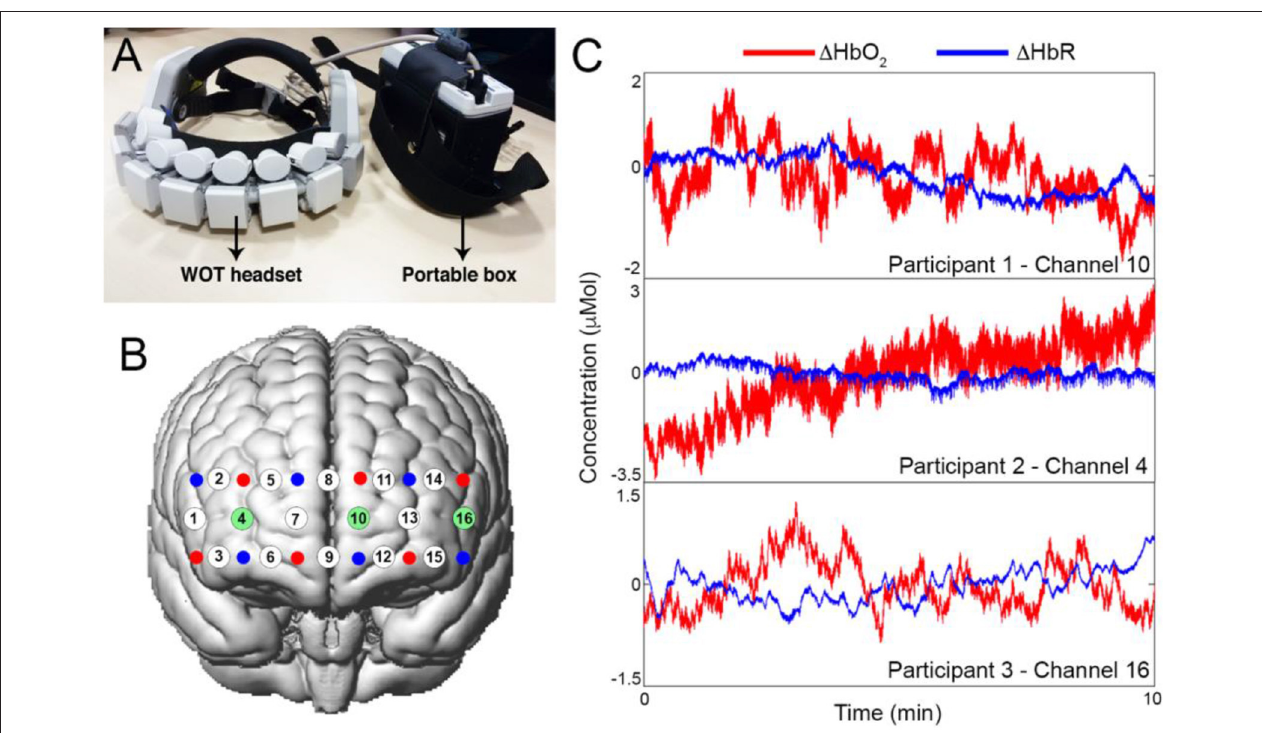
FIGURE 3 | (A) Hitachi Wearable Optical Tomography fNIRS device, and corresponding channels configuration onto the prefrontal cortex (B) . Sources are represented as red dots, detectors as blue dots and channels as white dots. Highlighted in green are the channels for which the corresponding time-series are presented in (C) . (C) shows examples of raw 1 HbO 2 and 1 HbR resting-state signals for one channel for each of three participants.